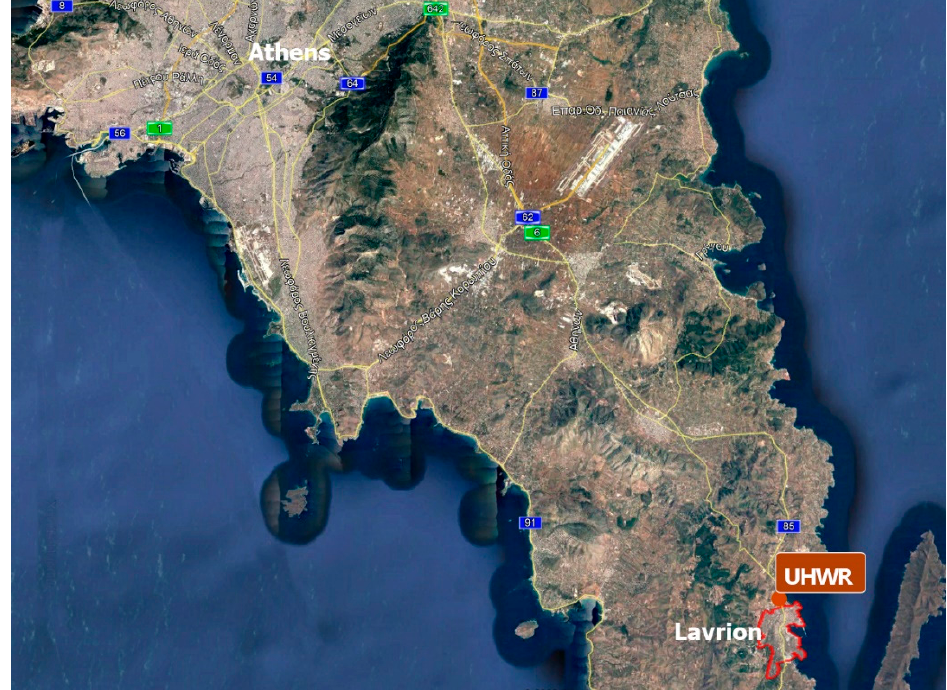
Figure 2. UHWR underground floor plan.